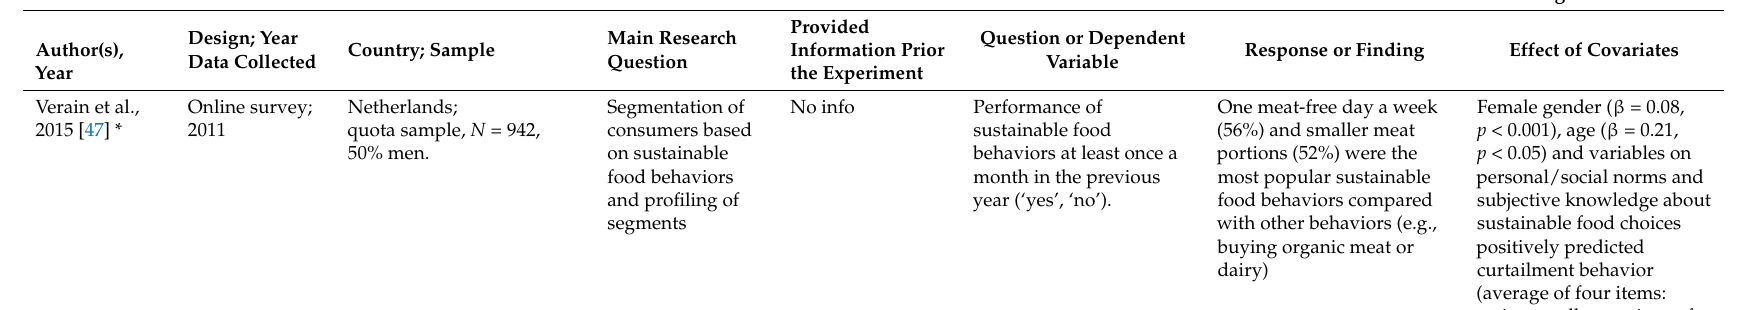
Table A3. Cont . Outcome Measure: Reason to Reduce Meat or Become